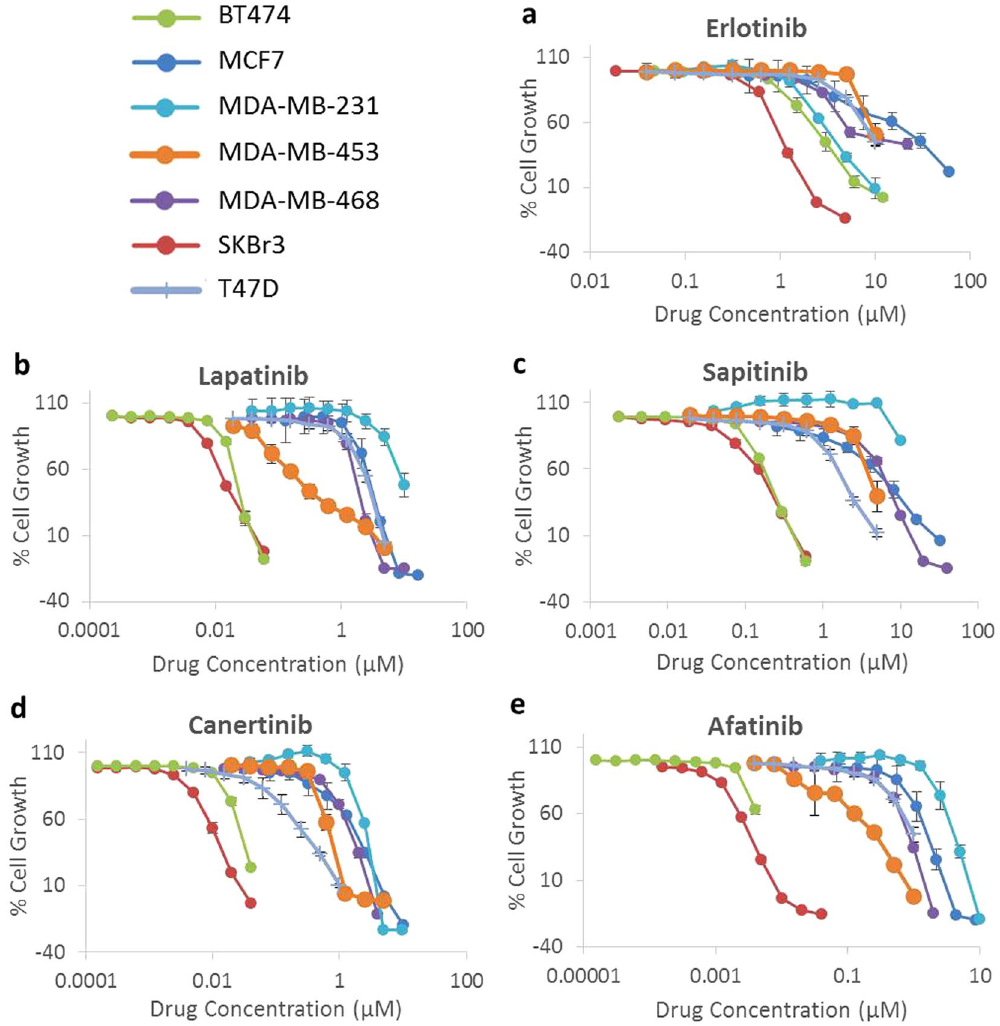
Figure 2. Growth control graphs showing effect of selected HER-family TKIs in doubling concentrations on growth of breast cancer cell lines. ( a ) EGFR reversible inhibitor erlotinib. ( b ) Dual EGFR/HER2 reversible inhibitor lapatinib. ( c ) Pan-HER reversible inhibitor sapitinib. ( d ) Pan-HER irreversible inhibitor canertinib. ( e ) Pan-HER irreversible inhibitor afatinib. Sulforhodamine B colorimetric assay was used to determine the effect of treatment of breast cancer cell lines with doubling dilutions of HER-family inhibiting TKIs. The irreversible pan-inhibitors (e.g. afatinib, canertinib, neratinib) were consistently more effective than the reversible dual and pan inhibitors (e.g. lapatinib, sapitinib), which were in turn more effective than the reversible EGFR inhibitors (e.g. erlotinib, gefitinib). Each point is a representative of the mean ± SD of triplicate